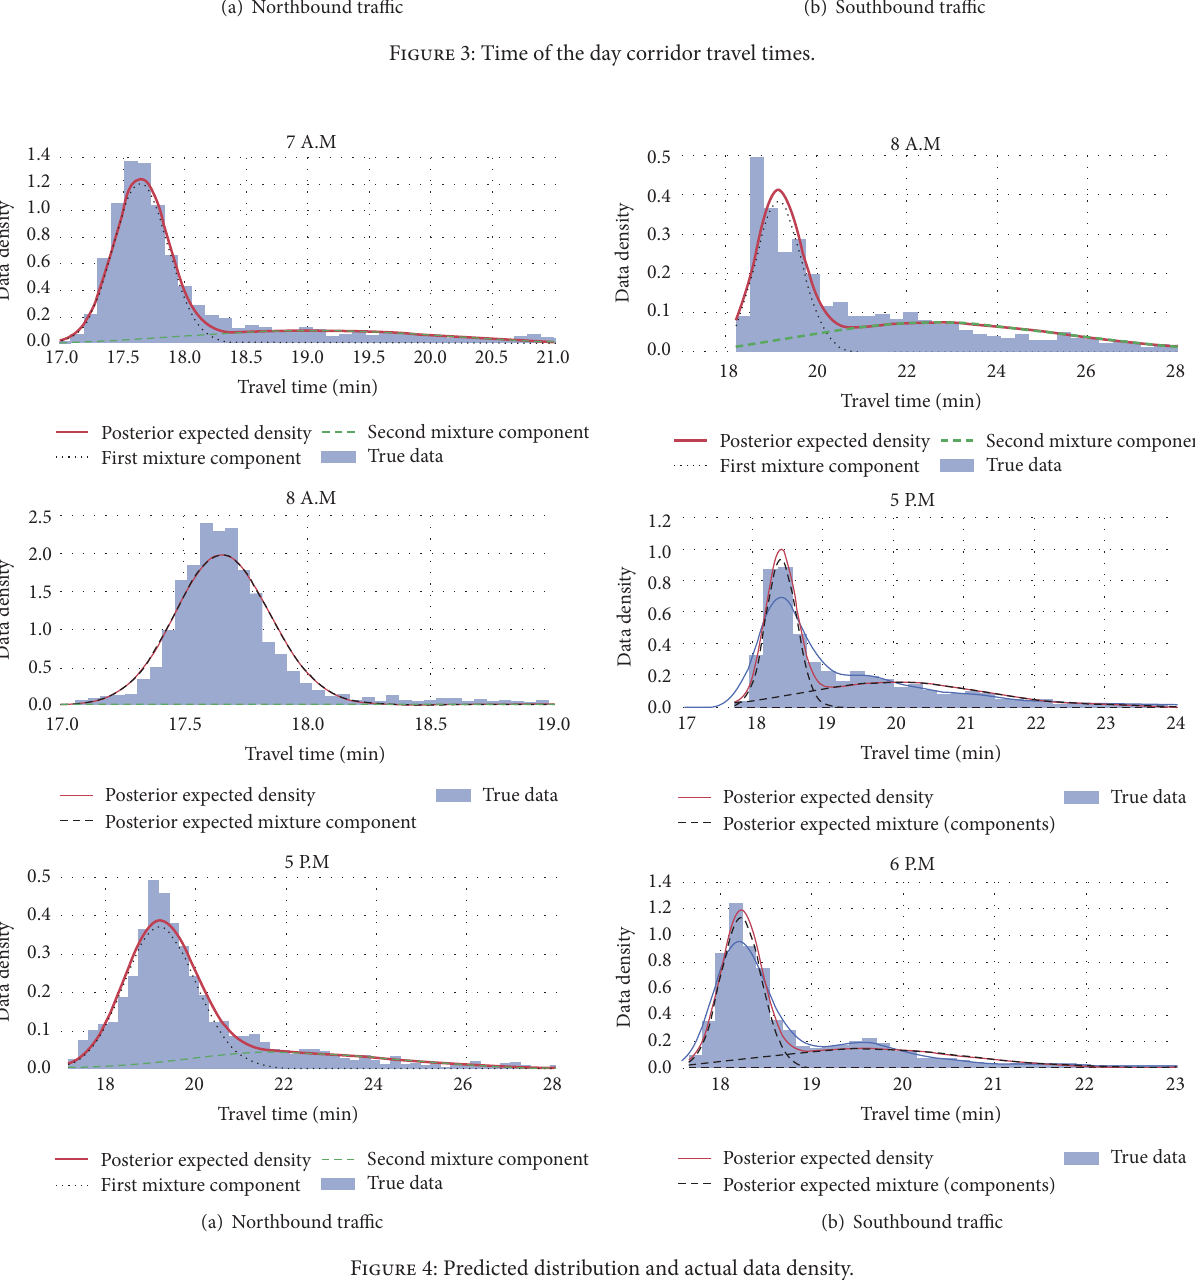
Figure 4: Predicted distribution and actual data